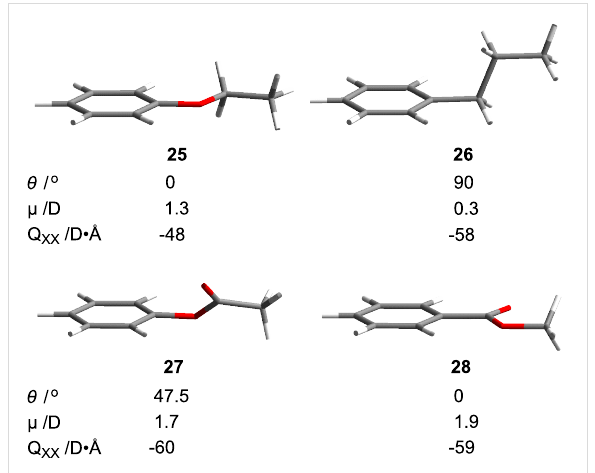
Figure 7: Equilibrium ground state geometries (B3LYP/6-31G(d)) for benzene derivatives: ethoxybenzene ( 25 ), propylbenzene ( 26 ), phenyl acetate ( 27 ), and methyl benzoate ( 28 ) and pertinent molecular para- meters: dihedral angle θ, dipole moment μ, and quadrupole moment tensor Q XX perpendicular to the ring